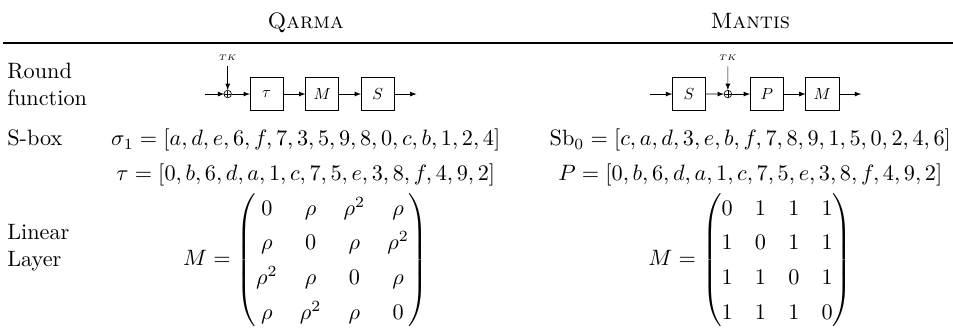
Table 2: Comparison between Mantis and Qarma . Qarma